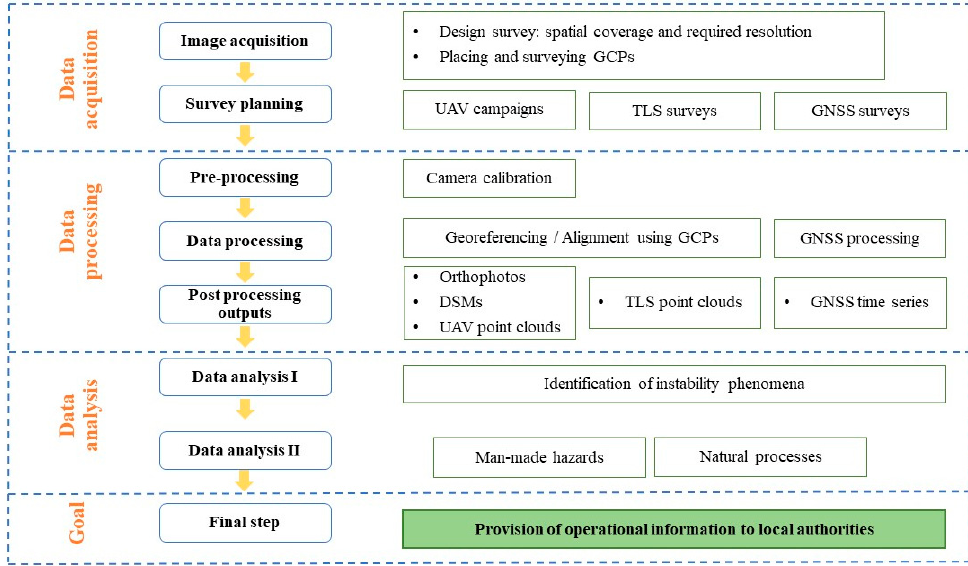
Figure 7. Distribution of the GNSS permanent pillars. The orthophoto presents the sliding area on 21 April 2019.